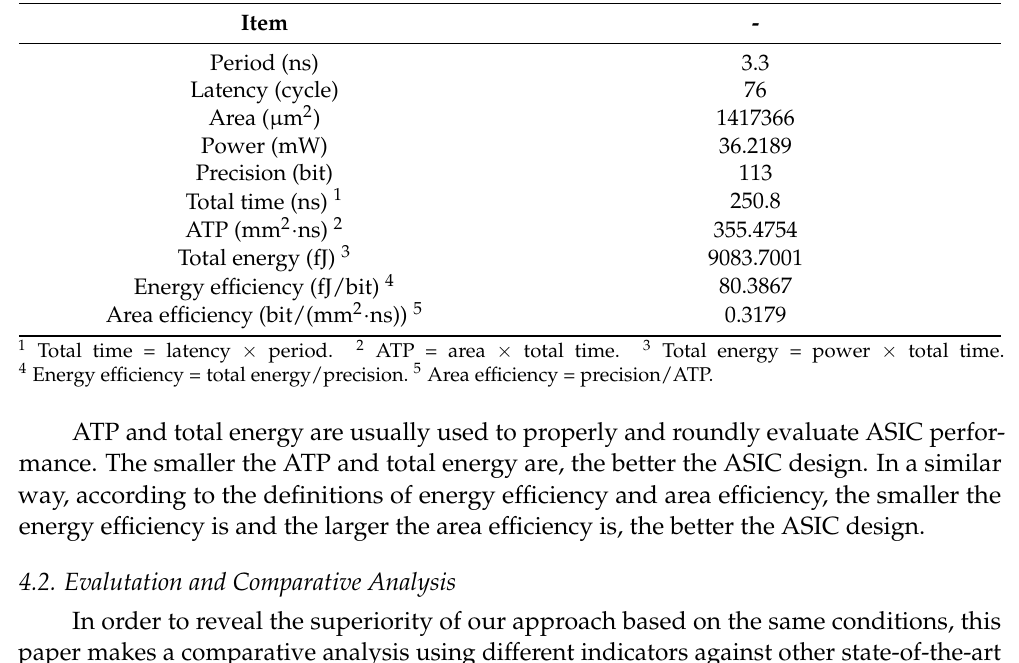
Table 3. ASIC Implementation Details @ TSMC 65